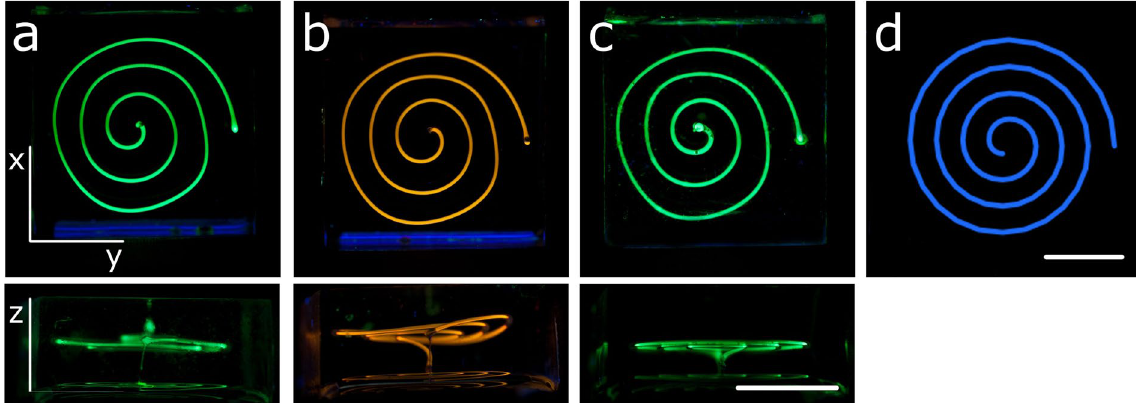
Figure 2. Distortions of printed structures in the z-plane and x/y-plane. Spirals of 400 µ m diameter were printed at 50 mm/min writing speed at ( a ) 6 min, ( b ) 15 min, and ( c ) 30 min PDMS curing time. The distortions in the z-plane occur due to sedimentation effects, higher curing time leads to more stability of the z-layers. Distortions in the x/y-plane occur due to the high viscosity of the PDMS matrix: ( d ) shows the original G-file image of structures ( a – c ). Channels were filled with an aqueous solution of dye and illuminated at 365 nm to increase visibility. Scale bars: 10